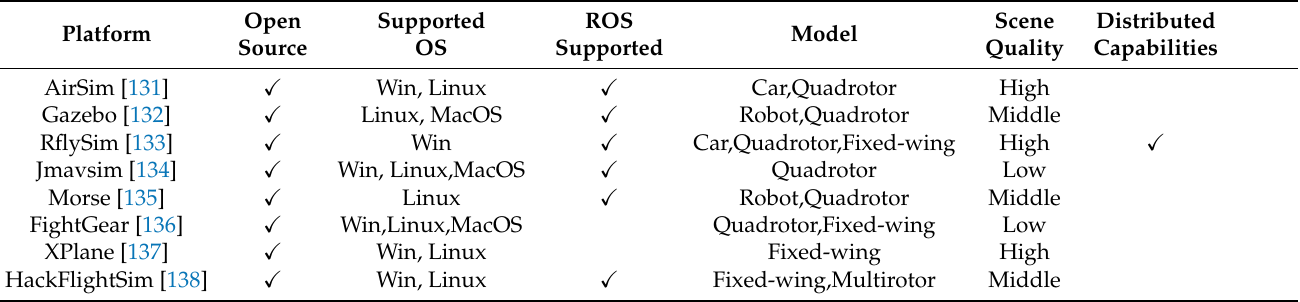
Table 5. Comparison between simulation